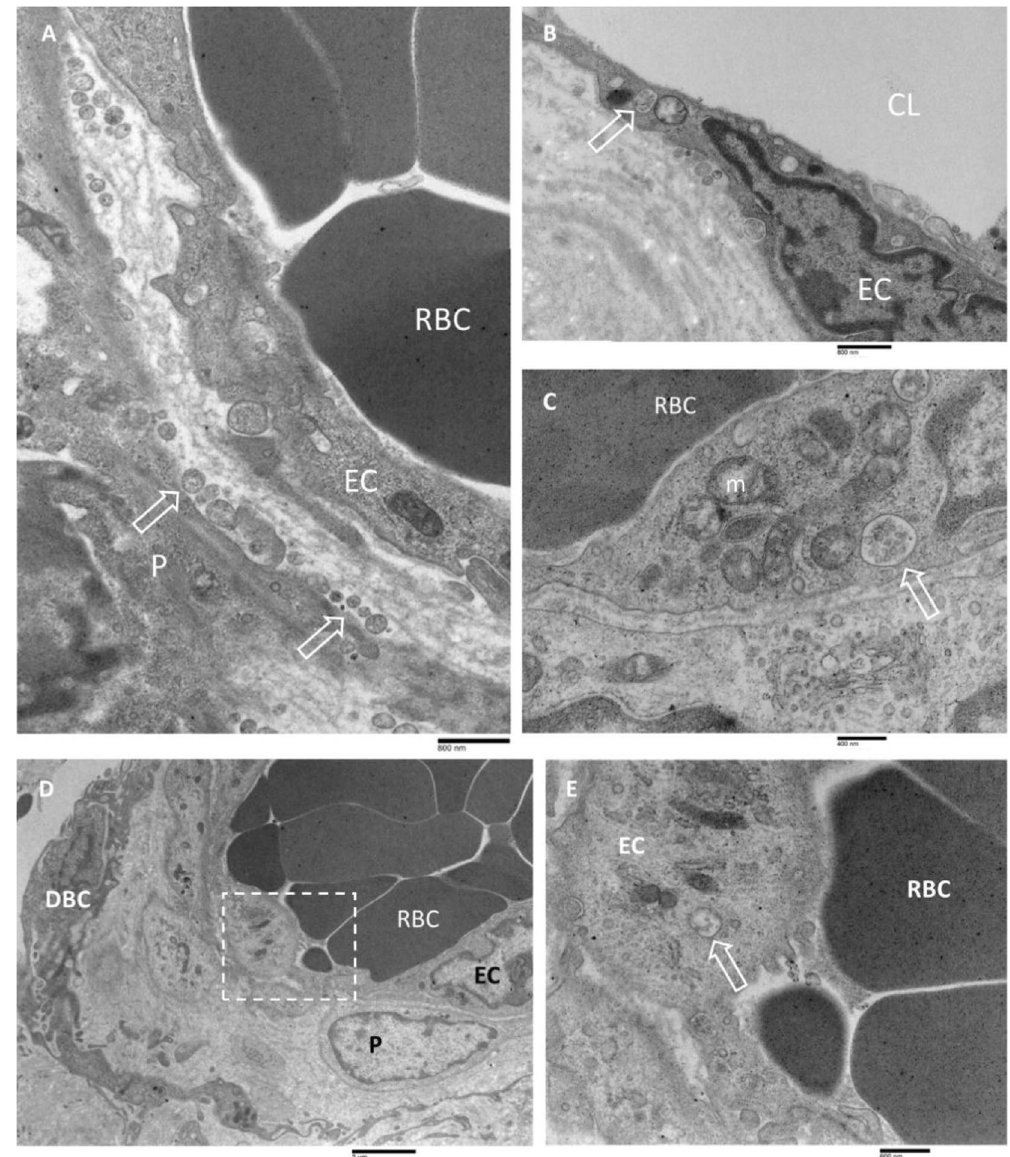
Figure 12. Transmission electron microscopy of capillaries in the CSDH inner membrane. ( A ) In the space between endothelial cells (EC) and pericytes (P) numerous microvesicles and exosomes (arrows) were seen. The basement membrane was discontinuous. RBC: red blood cells. 24,800 ×, bar = 800 nm. ( B ) Endothelial cell (EC) with an irregular nucleus, possessing a multivesicular body in the cytoplasm (arrows). Some microvesicles were detected in the extracellular space beneath the plasma membrane. Capillary lumen: CL; extracellular matrix: EM. 24,800 ×, bar = 800 nm. ( C ) Endothelial cells containing swollen mitochondria (m) and multivesicular bodies in the cytoplasm (arrow). Red blood cell: RBC; pericyte: P. 44,900 ×, bar = 400 nm. ( D ) dilated capillary containing numerous red blood cells (RBC) in the lumen. As provided by clear cytoplasm, some pericytes (P) were observed surrounding endothelial cells (EC), DBC: dural border cell. 10,900 ×, bar = 2 µm. ( E ) A closer view of a boxed area in ( D ). An endothelial cell (EC) contains in their cytoplasm some mitochondria, numerous micropinocytosis vesicles, and multivesicular bodies (arrow). 28,600 ×, bar = 600